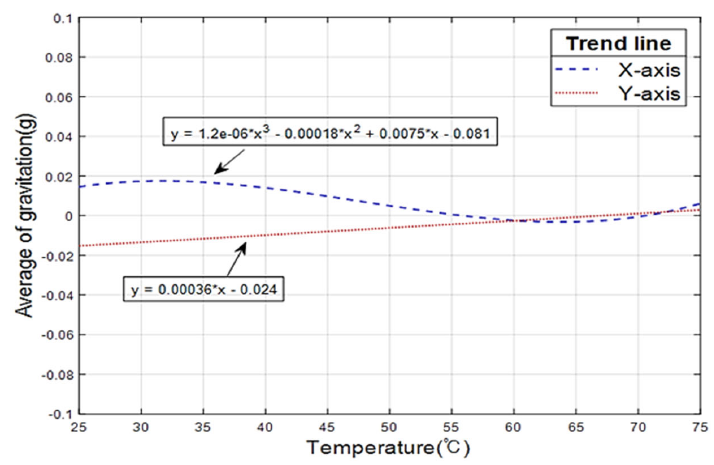
Figure 5. Trendline of the measured values with temperature in the X and Y-axes of the accelerom ‐ eter.